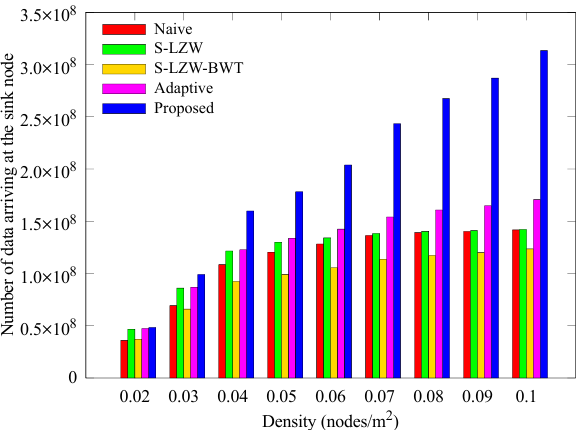
Figure 10. Change in the number of data arriving at the sink node with various node